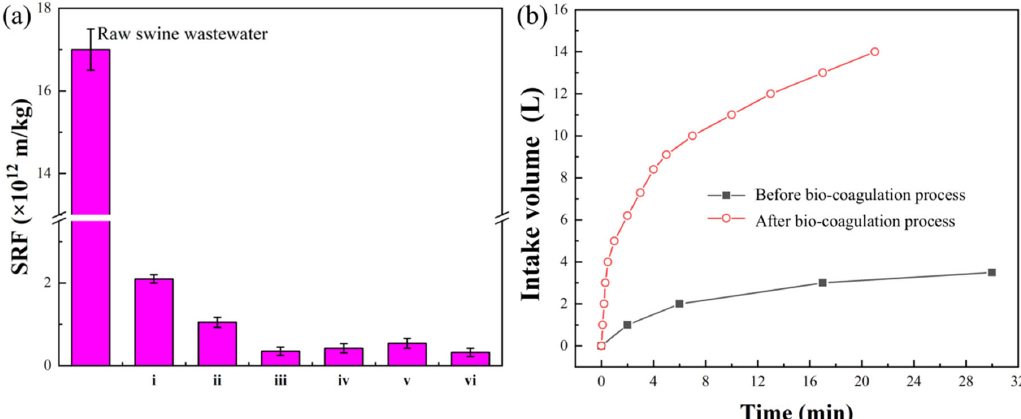
Figure 2. ( a ) SRF of the concentrated swine slurry after bio–coagulation with different dosages of dewatering agents and ( b ) intake volume of the swine slurry pumped into a filter press before and after the bio–coagulation process. Table 2. The primary properties of the semi–drying slurry cake after biological coagulation dewater ‐ ing treatment.